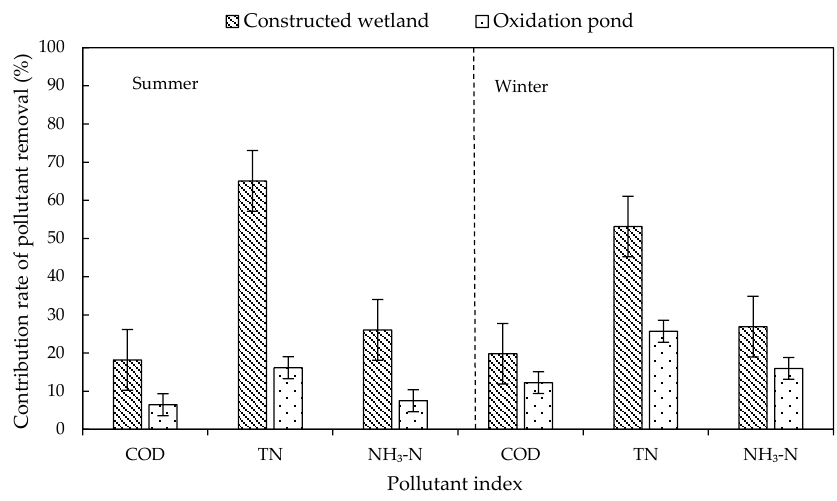
Figure 4. Variation in contribution rate of pollutant removal rate in ecological units.